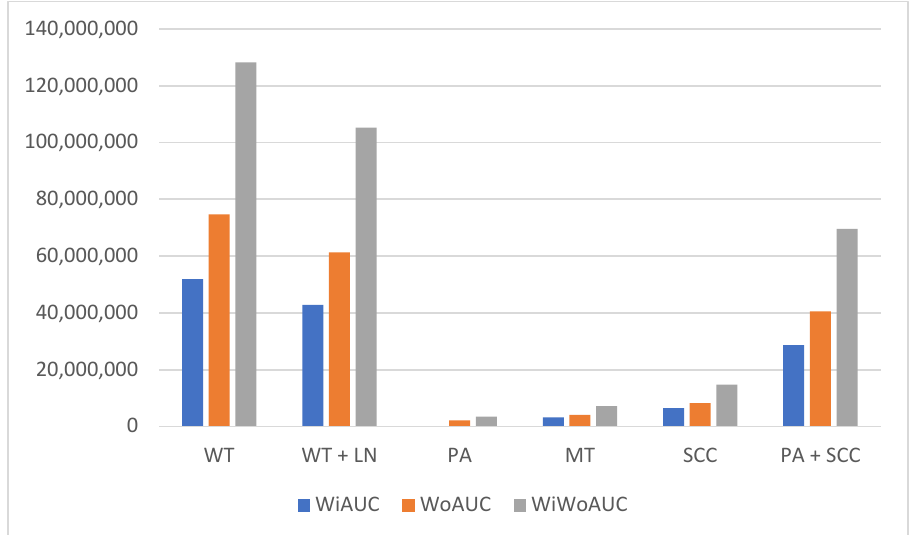
Figure 3. Bar graph depicting the significant differences between parotid gland tumors in the CEUS intensity parameters WiAUC (wash-in area under the curve), WoAUC (wash-out area under the curve), WiWoAUC (wash-in/wash-out area under the curve). X-axis: different parotid gland tumors WT (Warthin’s tumor); WT + LN (Warthin’s tumors + lymph nodes); PA (pleomorphic adenoma); MT (malignant tumors); SCC (squamous cell carcinoma); PA + SCC (pleomorphic adenoma + squamous cell carcinoma). Y-axis: mean intensity values of WiAUC, WoAUC, and WiWoAUC given in arbitrary units [a.u].